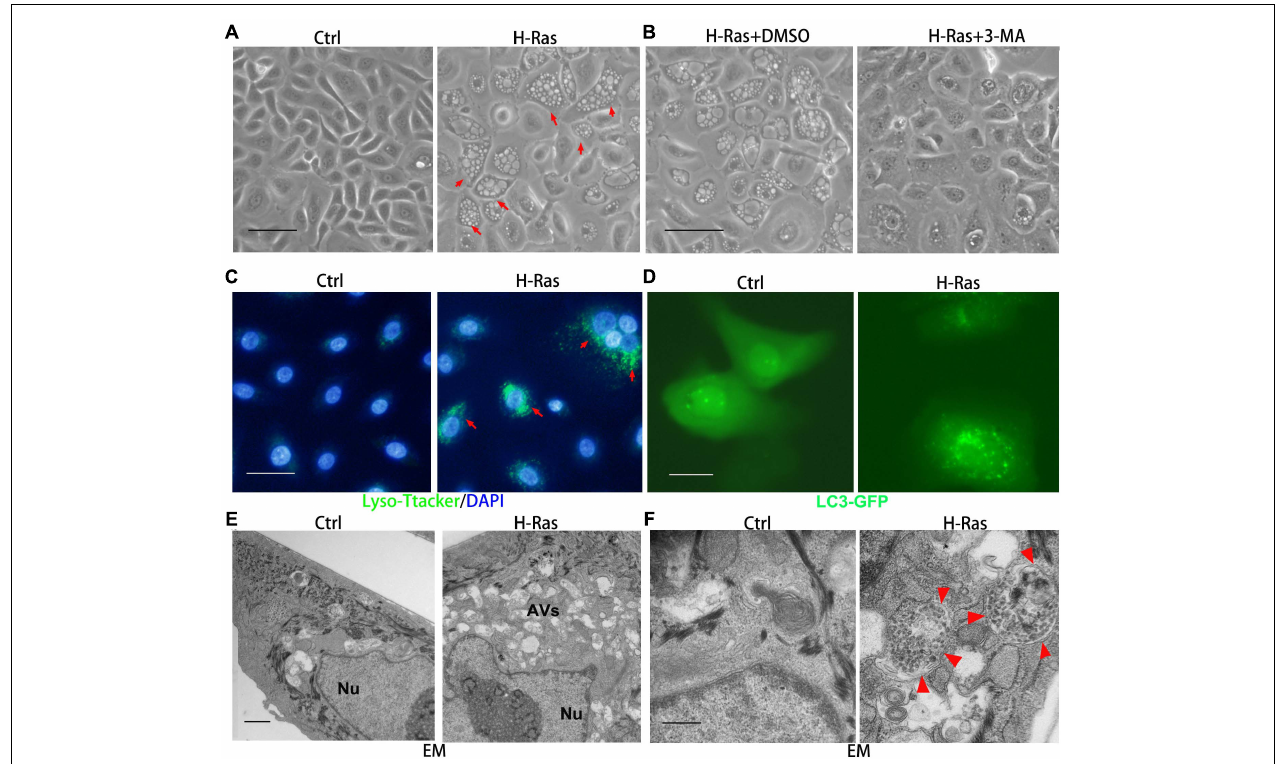
FIGURE 1 | H-Ras induces autophagic vacuoles in human keratinocytes. (A) Human keratinocytes were infected with a H-Ras G 12 V expressing or a control retrovirus. Representative cell images 24 h after infection are shown, red arrows indicate cells with bubbles. (B) Representative images of human keratinocytes at 24 h after infection with a H-Ras G 12 V expressing retrovirus plus treatment with DMSO as a control or with a PI3K inhibitor (3-MA). (C) Human keratinocytes were infected with a H-Ras G 12 V expressing or a control retrovirus, at 24 h after infection, LysoTracker Green was added into the growth medium plus DAPI (blue for nuclei) for 5 min, then examined using a fluorescence microscope. (D) Human keratinocytes were transfected with a LC3-GFP expression vector, and after transfection, the cells were infected with a H-Ras G 12 V expressing or a control retrovirus. At 24 h after infection, the cells were checked for GFP expression using a fluorescence microscope. (E,F) Human keratinocytes were infected with a H-Ras G 12 V expressing or a control retrovirus. At 24 h after infection, the cells were processed for electron microscopic (EM) analysis. Low magnification images are shown in panel (E) , and high magnification images are shown in panel (F) . Nu: nuclei, AVs: autophagic vesicles, red arrows indicate the double membrane structure of autophagosomes. (A–D) Bars = 50 mm, (E) bar = 2 mm, and (F) bar = 100